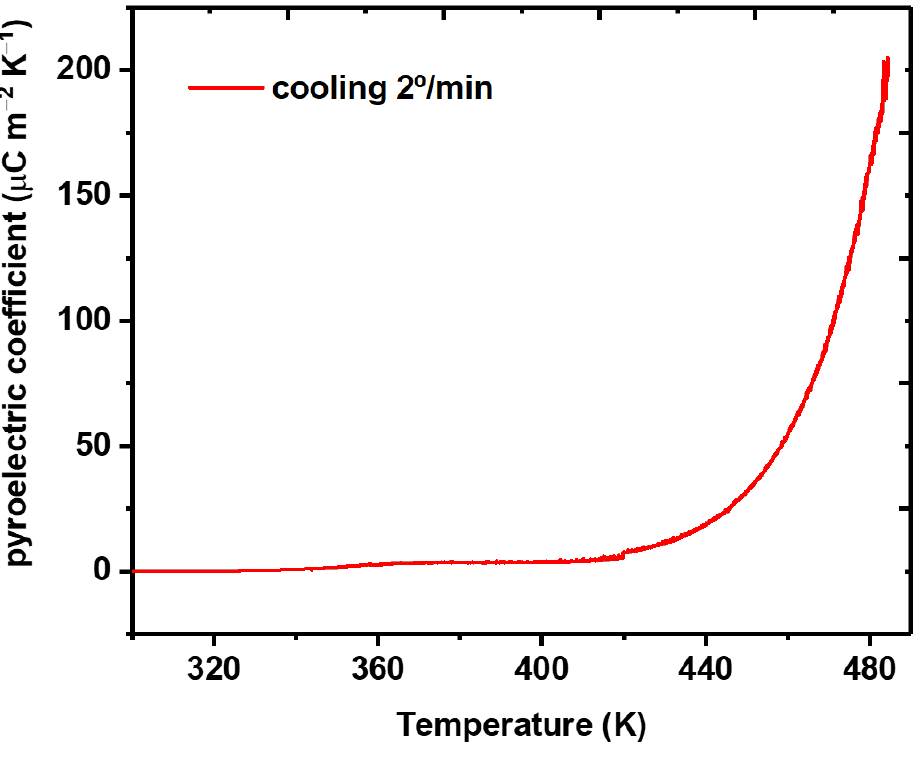
Figure 11. Pyroelectric coefficient as a function of the temperature of MDABCO-NH 4 I 3 @PA66 nanofibers, measured on cooling from the Curie transition temperature.